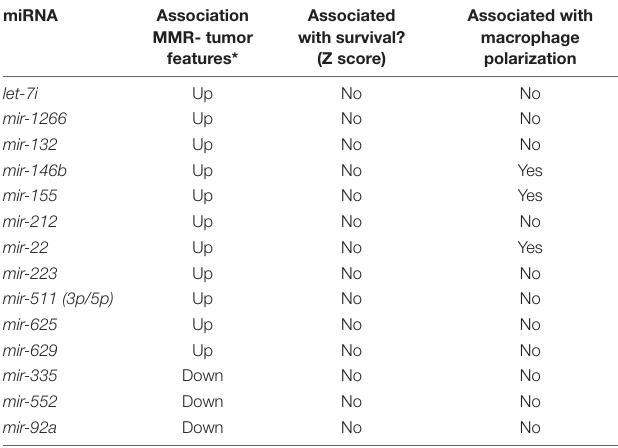
TABLE 1 | miRNAs associated with 3 tumor